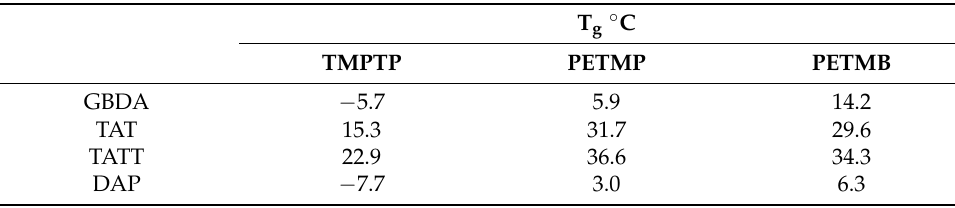
Table 5. Glass transition temperature of thiol–ene polymers (obtained in bulk polymerization).